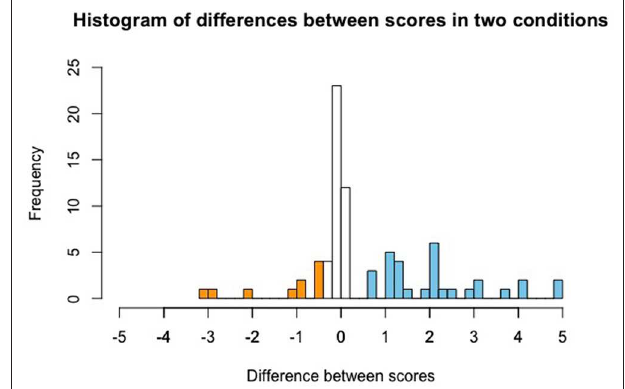
FIGURE 4 | Histogram of differences in scores between conditions: contrastive condition minus non-contrastive condition. Differences below − 0.5 are marked in orange color, differences above 0.5 are marked in blue color. Orange bars thus indicate participants who gave a higher score in the non-contrastive condition, non-colored bars indicate participants who gave a similar score in both conditions, and blue bars indicate participants who gave a higher score in the contrastive